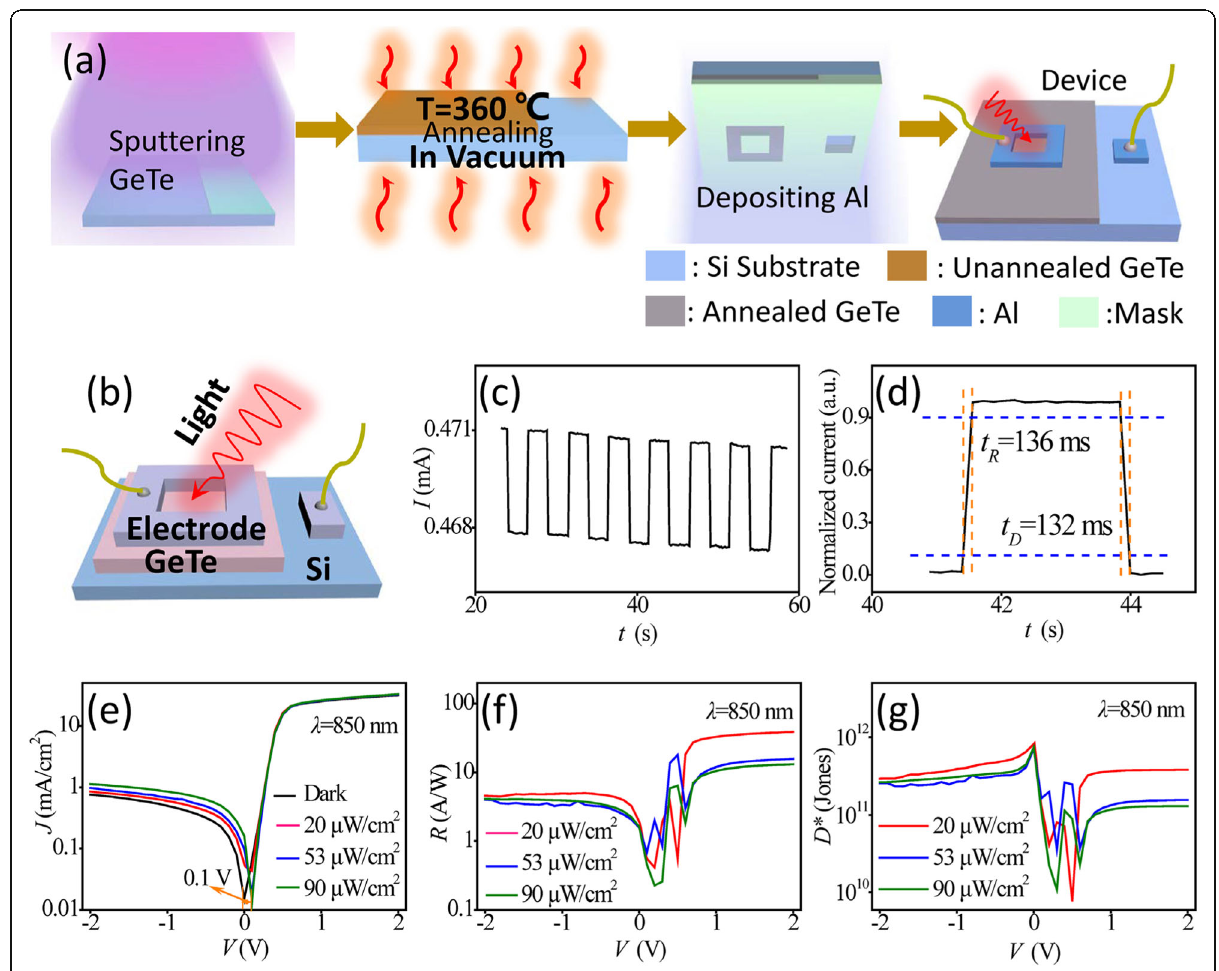
Fig. 3 a Schematic diagrams illustrating the fabrication process of photovoltaic detector based on p-GeTe/n-Si heterojunction and b the device structure. c – d Temporal photoresponse of the device. e Plots of log( J ) -V characteristics of the photovoltaic detector under dark (black line) and different irradiation densities (colored lines). f Plots of R (responsivity)- V and g D * (detectivity)- V characteristics of the photovoltaic